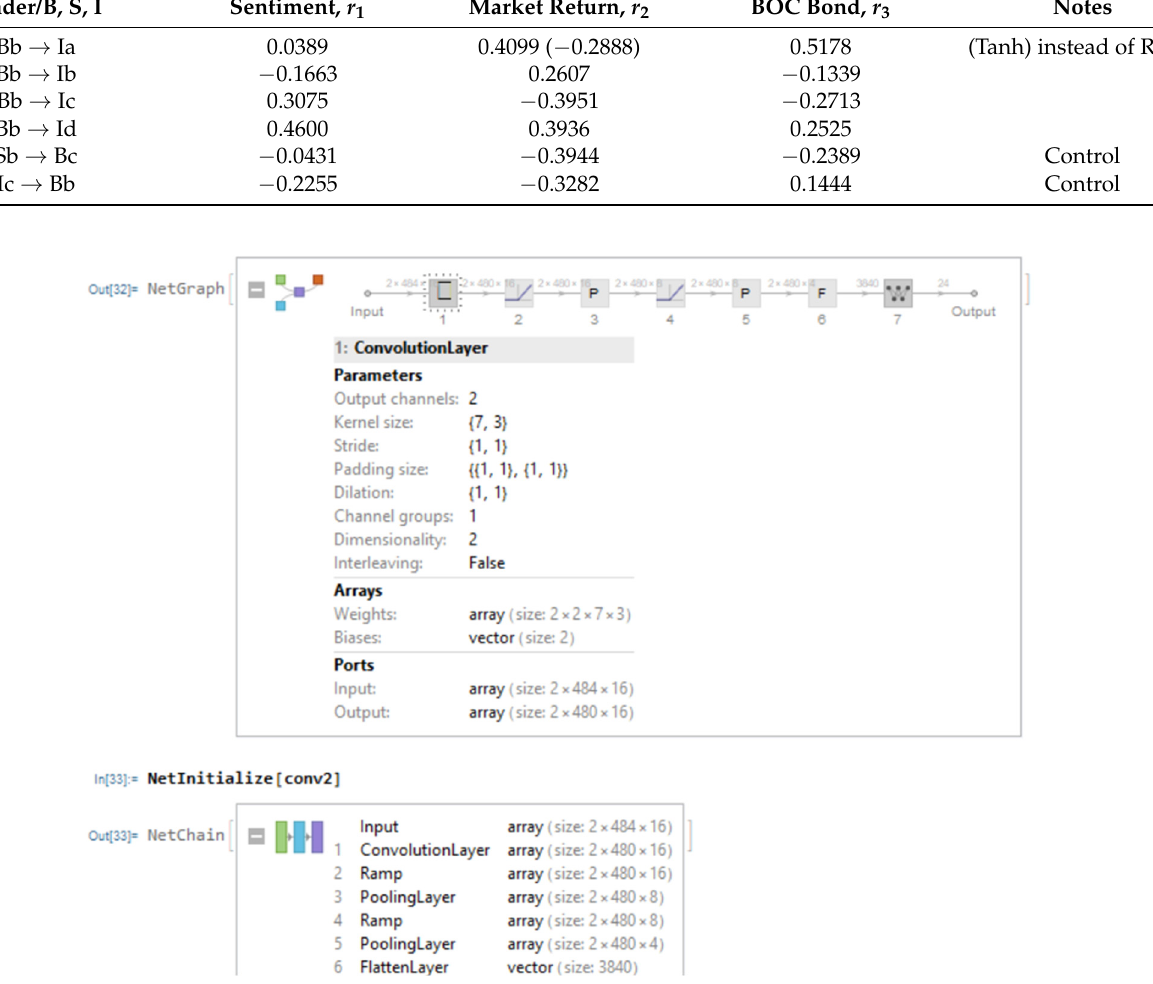
Figure A4. Sketch of the 7-layer CNN network.